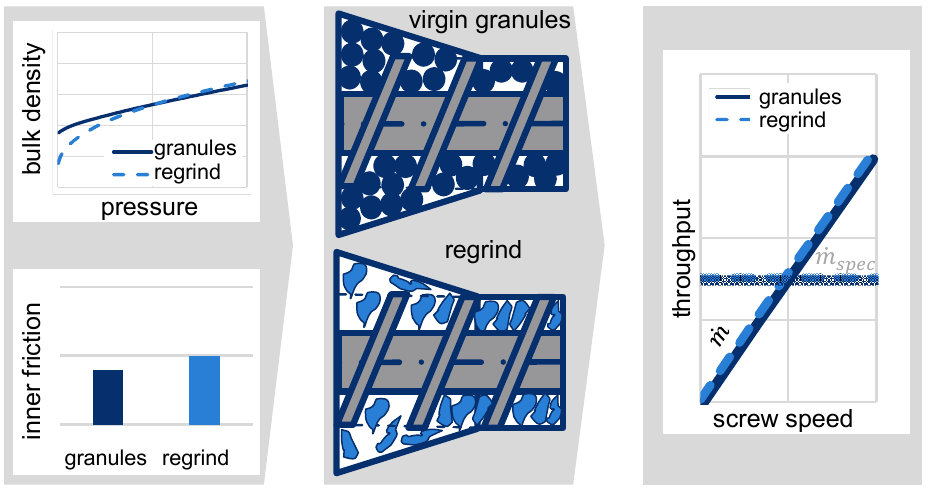
Figure 8. Visualization of the theorem.